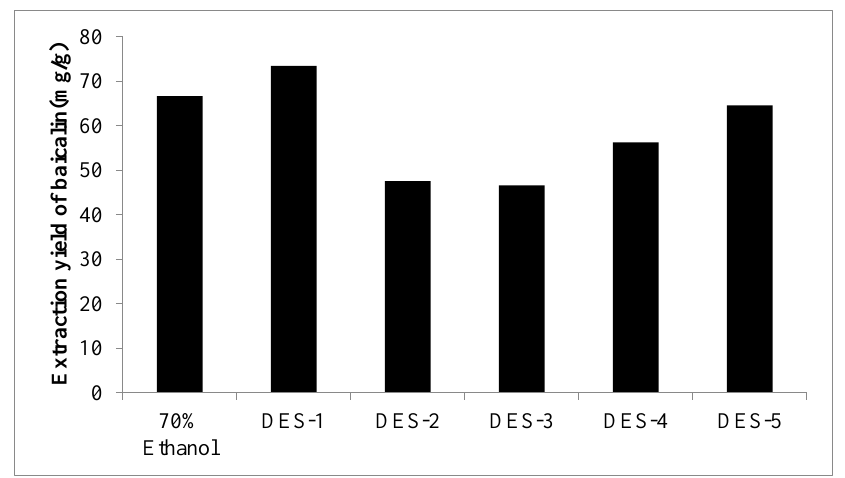
Figure 1. Extraction yield of baicalin using different types of DESs.